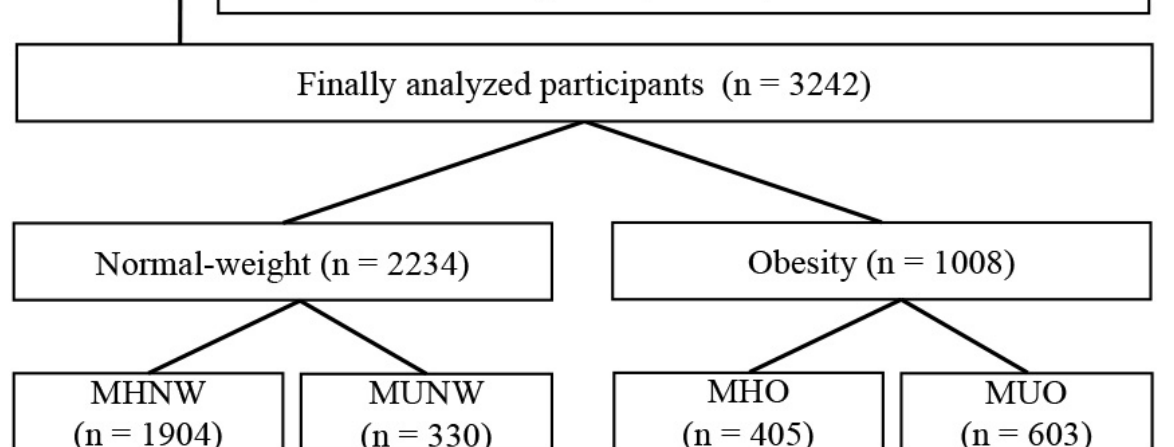
FIGURE 1. Participants’ inclusion and exclusion diagram. PA: physical activity; MHNW: Metabolically Healthy Normal Weight; MUNW: metabolically unhealthy normal weight; MHO: metabolically healthy obesity; MUO: metabolically unhealthy